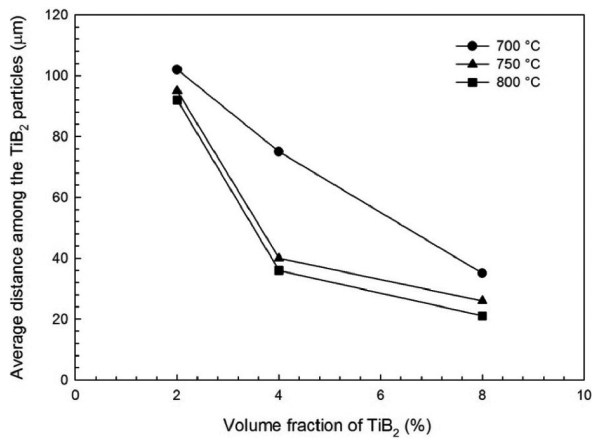
Fig. 4: The changes in average distance among the TiB 2 particles as